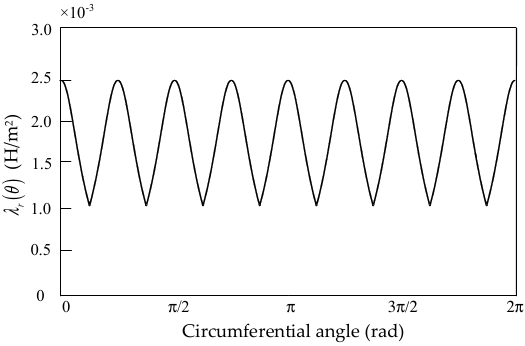
Figure 2. Air-gap permeance waveform of air-gap eccentricity.